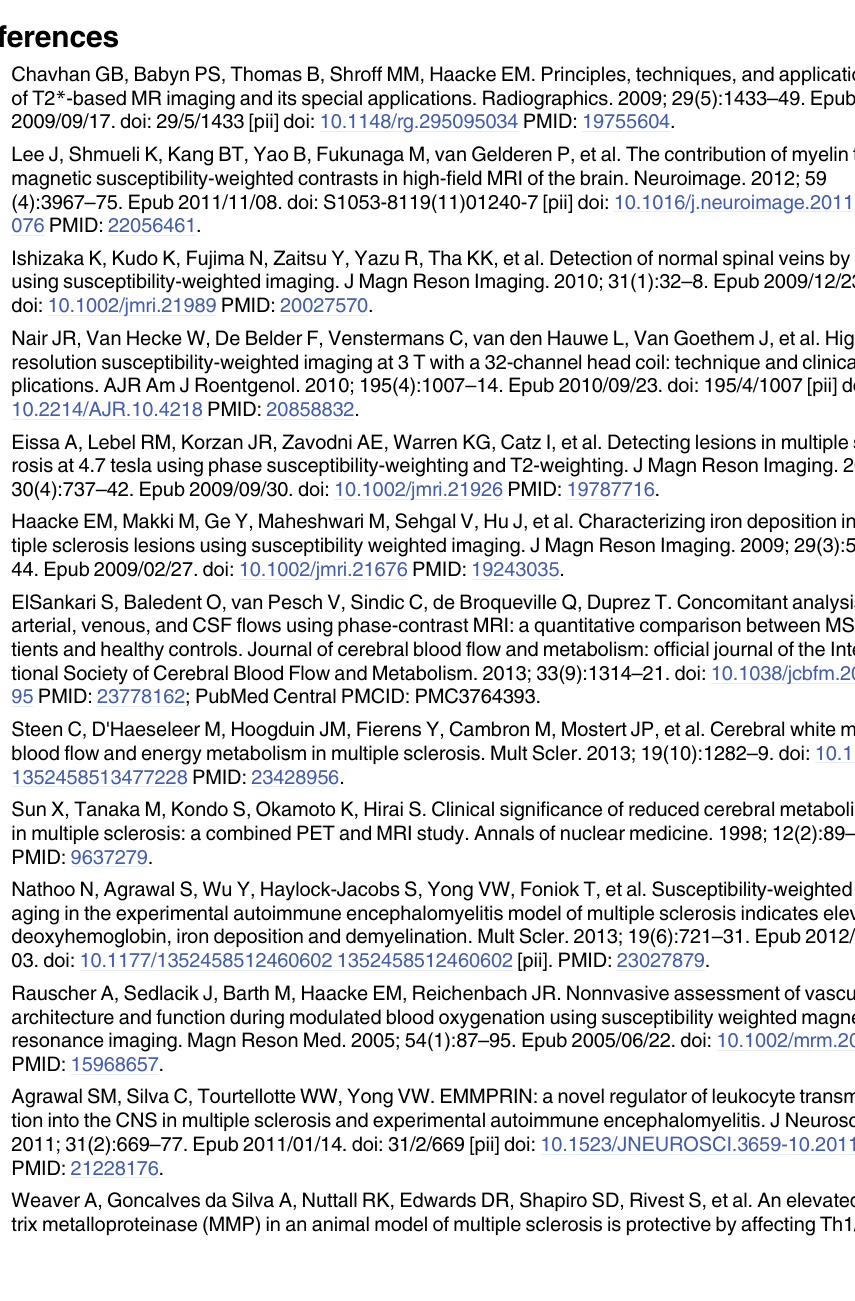
S2 Table. Respiration and temperature data for animals in study. S3 Table. SWI hypointensity counting